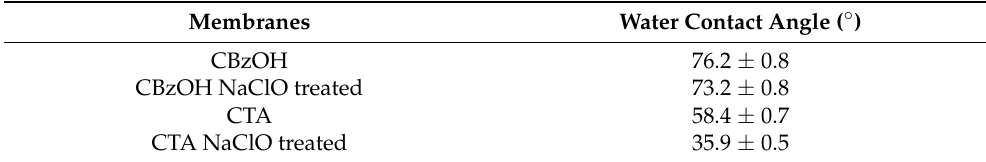
Table A6. Water Contact angles of cellulose derivative films before and after sodium hypo- chlorite